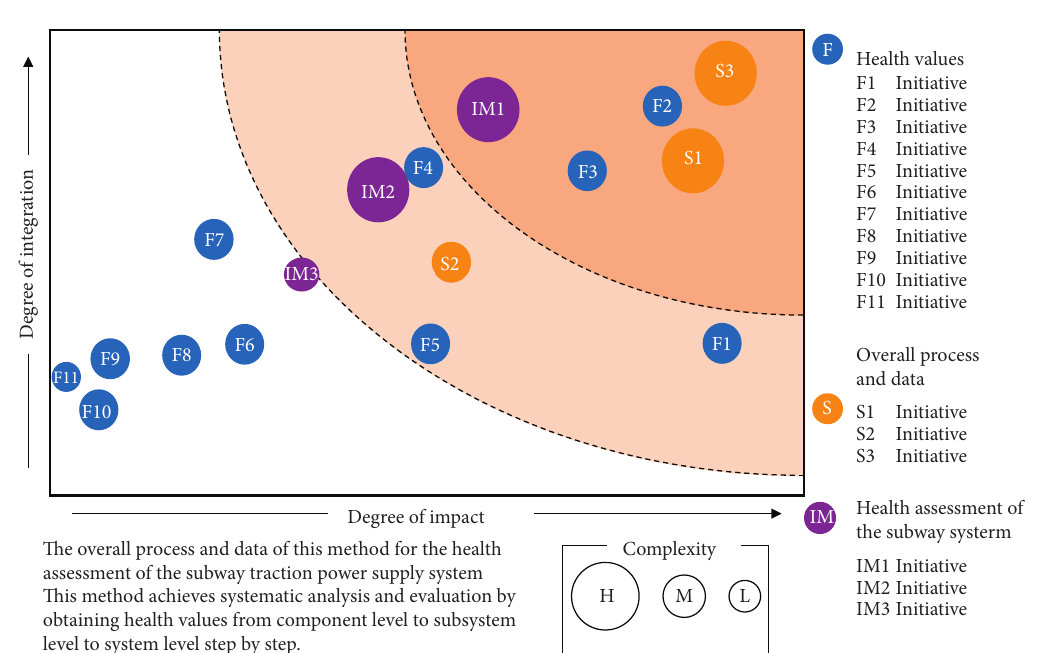
Figure 9: Method achieves systematic analysis and evaluation by obtaining health values. The degree of color means the importance level of all the impact.